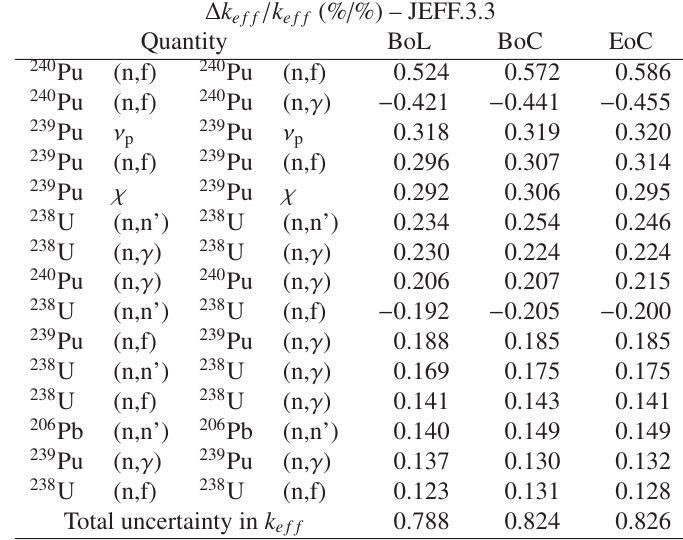
Figure 1. ALFRED core model.